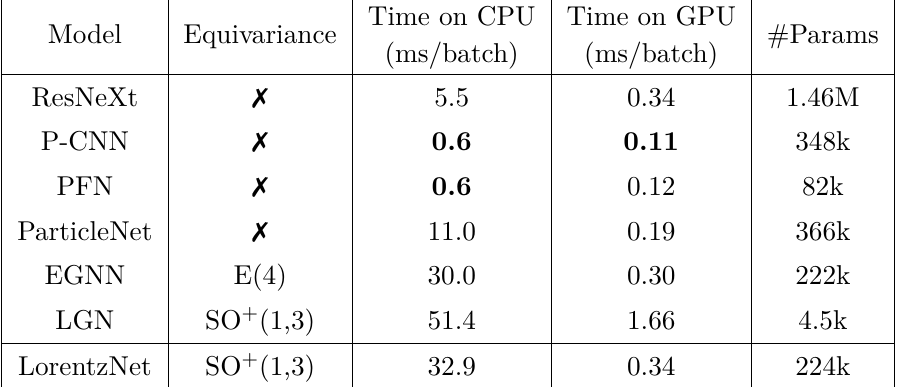
Table 5 . Inference time of each model on both CPU and GPU along with their parameter numbers. Models are executed on a cluster with an Intel Xeon CPU E5-2698 v4 and an Nvidia Tesla V100 32GB. All the inference times are collected with a batch size of